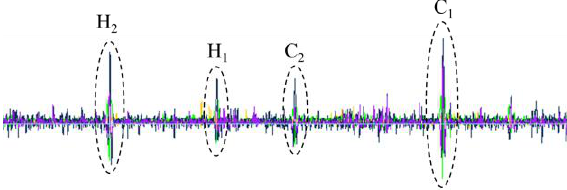
Figure 16. The drill pipe sample with four defects (unit: mm). Figure 17. The typical MFL testing signals for the drill pipe at the wellhead.